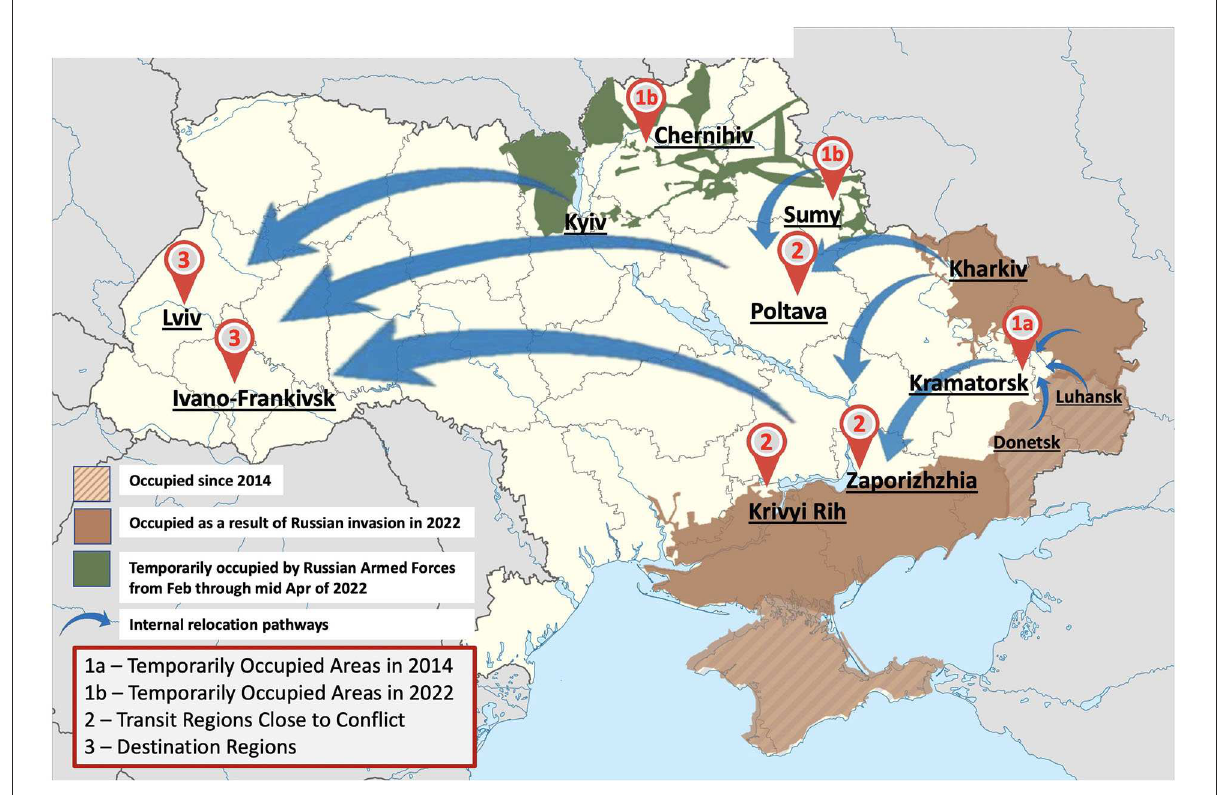
FIGURE1 Interview site map relatively to the war situation in Ukraine as of April 15 th ,